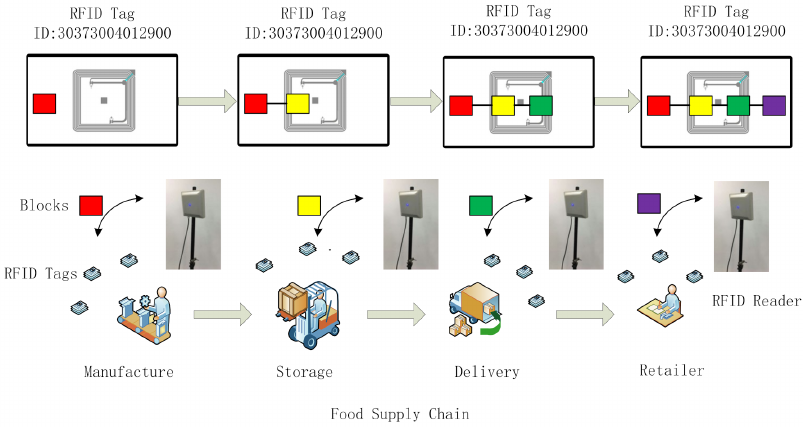
Figure 5. Work procedure of the RFID system (The color is used to distinguish the blocks from different sessions in the supply chain.). Table 2. Sample record for a single product data structure